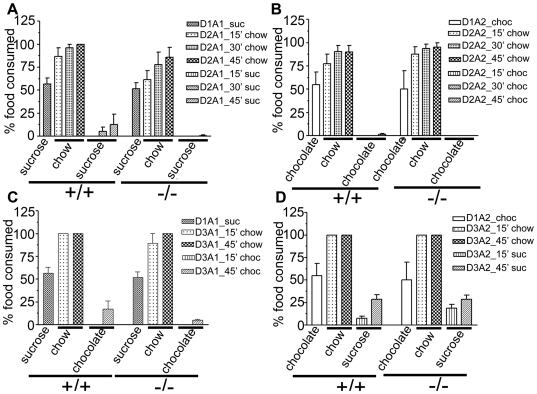
Normal behavior of Atxn2 ko mice in the conditional taste aversion task.Panels A and B show results from the Conditional Taste Aversion test on days 1 and 2; panels C and D show the results from neophobia testing on day 3. On conditioning day 1, mice in group A1 (wt, n = 6; ko, n = 7) were exposed to regular chow and sucrose, whereas mice in group A2 (wt, n = 8; ko, n = 5) were exposed to chow and chocolate. Wild type mice consumed 56.7%±6.7 of sucrose pellets and 55%±13.3 (n = 8) of chocolate pellets. Atxn2 ko mice consumed 51.3%±6.3 and 50.0%±20.0 of sucrose or chocolate pellets, respectively. A) Group A1 mice exhibited strong taste aversion to sucrose pellets on the testing day. At 45 min, wt and Atxn2 ko mice consumed 100±0.0% (mean±SEM) and 85.7±10.7% of rodent chow pellets, respectively, while only 12.5±11.5% and 0.7±0.7% of sucrose pellets were consumed by wt and Atxn2 ko mice, respectively. B) Group A2 mice showed strong taste aversion to chocolate pellets. At 45 min, wt and tax ko mice consumed 90.0±6.6% and 95.0±5.0% of rodent chow pellets, respectively. C, D) Neophobia test of wild type and Atxn2 ko mice. Mice from group A1 (C) were fed chocolate-coated pellets, and conversely animals in group A2 (D) were fed sucrose pellets. Animals in both groups showed evidence of neophobia, irrespective of genotype. Percentage of food pellets (chow, sucrose, and chocolate) consumed at 15 and 45 minutes are shown. Differences between wild type and Atxn2 ko mice were not significant (2-way ANOVA, P>0.05).